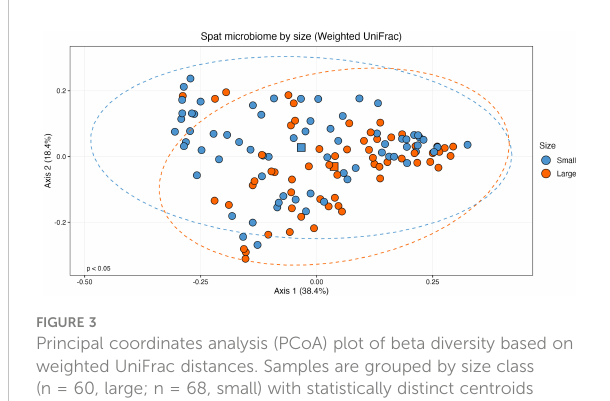
FIGURE 3 Principal coordinates analysis (PCoA) plot of beta diversity based on weighted UniFrac distances. Samples are grouped by size class (n = 60, large; n = 68, small) with statistically distinct centroids (PERMANOVA: F(1, 126) = 2.532, p < 0.05). Ellipses show 95% con fi dence intervals of the centroid estimates of the community structures of each size class. The centroid of each size class is shown as a square.